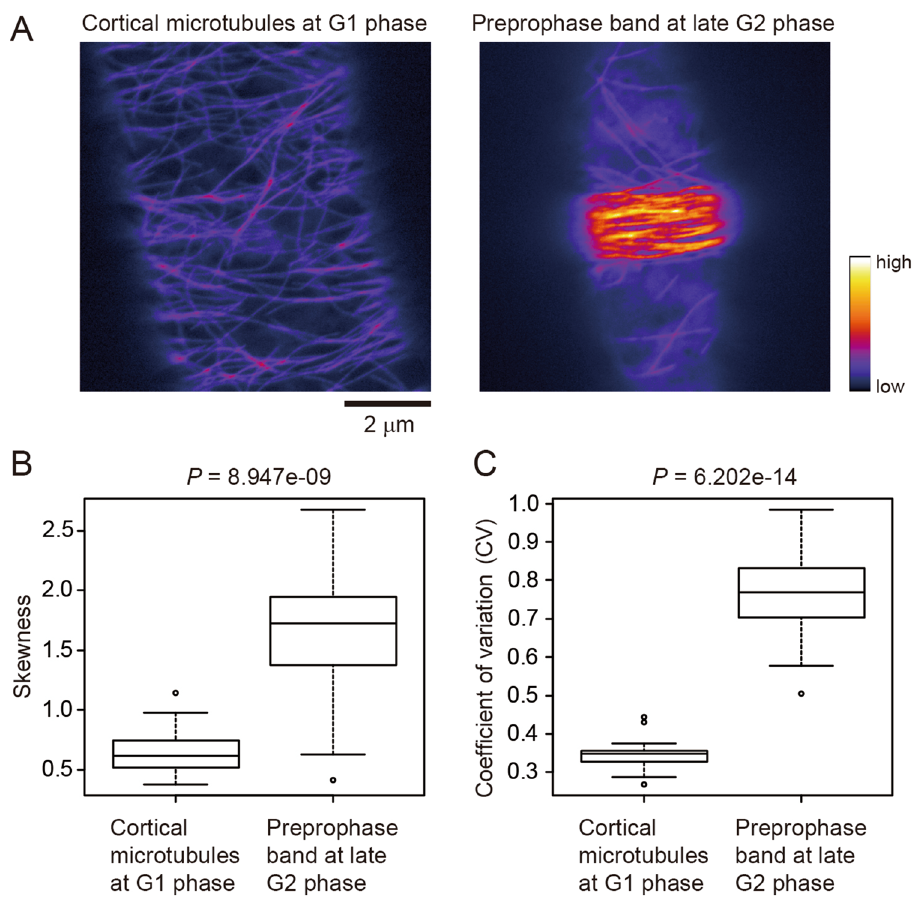
Figure 3. Evaluation of microtubule bundling in vivo. ( A ) Representative confocal laser scanning microscopy images of yellow fluorescent protein (YFP)-tubulin-labeled microtubules in tobacco BY-2 cells. Cortical microtubules at the G1 phase (left) and highly bundled cortical microtubules in the preprophase band (right) are shown. Scale bar indicates 2 μm. ( B ) Skewness of the intensity distribution. ( C ) CV of the intensity distribution. Significance was tested using the Mann–Whitney U-test. N =